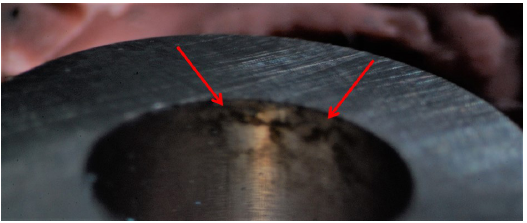
Figure 11. Crevice corrosion regions observed after CPT test for UNS N06625 sample, detached from the thermosetting